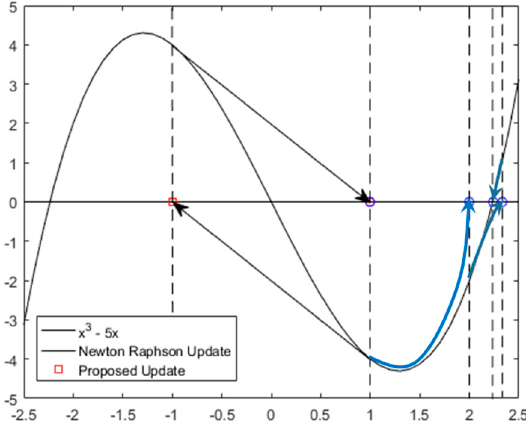
Figure 2. Comparison in the convergences of the Newton ‐ Raphson method and proposed methods.